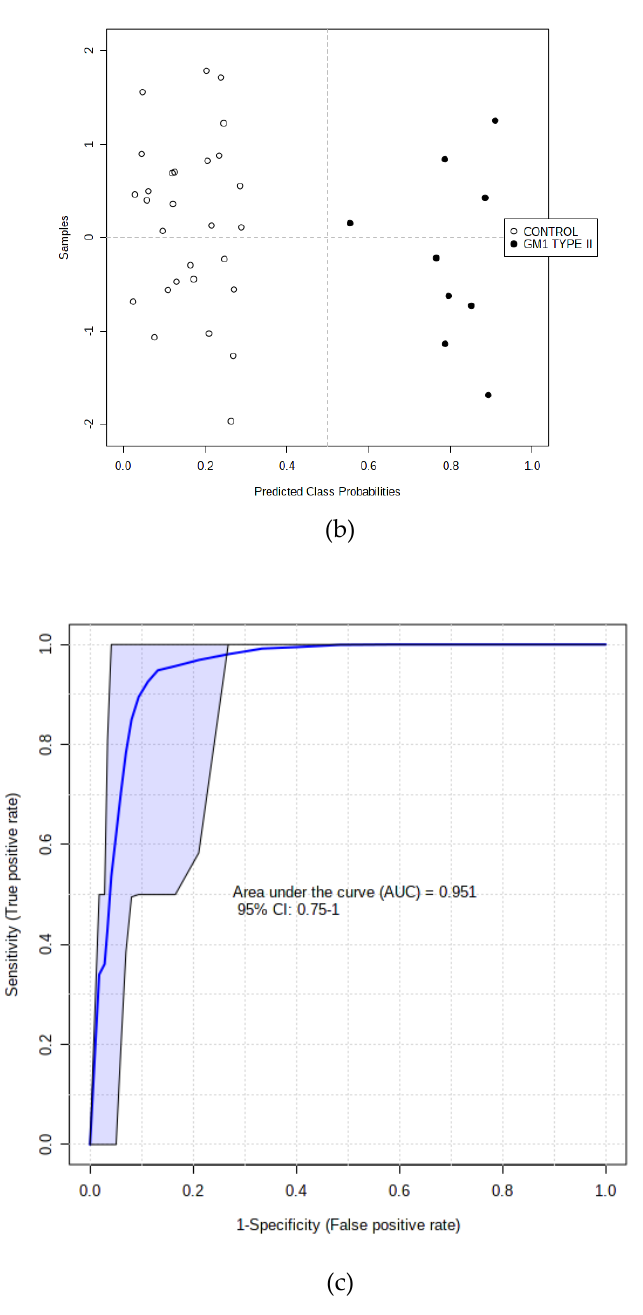
Figure 4. ( a ) Receiver-operating characteristic (ROC) curves arising from a linear kernel SVM-based cross-validation analysis of the Model 1 ISB-containing dataset for systems with 2–25 variables. ( b ) Predicted class probability plot for the most effective system for Model 1 featuring 10 predictor variables (all samples were correctly classified). ( c ) Corresponding ROC curve for analysis of the Model 2 dataset, showing the best system with only 5 predictors; 95% CIs are also shown.